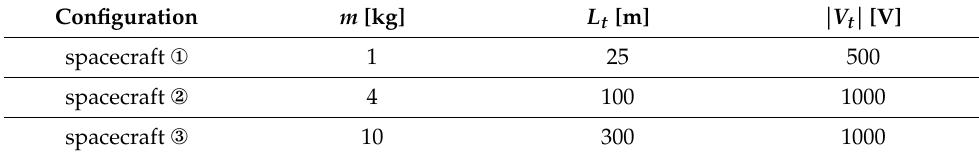
Table 1. Characteristics of the PB-based small satellites in the deorbiting simulations.